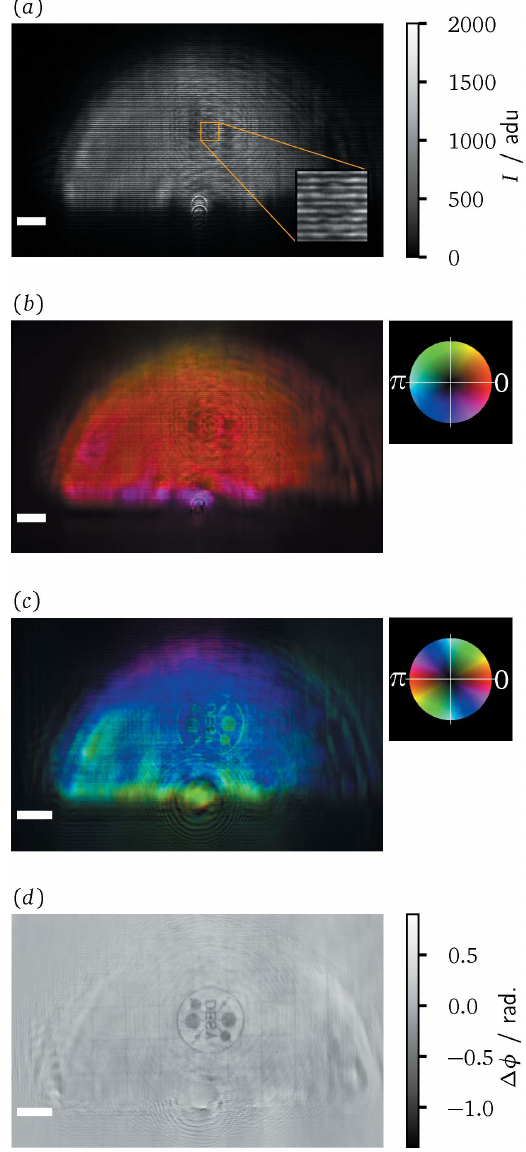
Figure 4 Overview of the data evaluation for grating interferometry. ( a ) Dark frame corrected raw data for a sample measurement in analog digital units (adu) of the sCMOS camera. The inset highlights the interference pattern over a region of 100 (cid:5) 100 pixels. ( b ) Complex wavefield reconstructed from this single-exposure data via the SIR method. The amplitude is mapped to brightness and the phase to hue, as indicated by the adjacent colour wheel. ( c ) Wavefield after backpropagation to the sample plane. ( d ) Phase shift of the sample after reference correction. The scale bar indicates 1 mm length in panels ( a ) and ( b ) and 10 m m in ( c ) and ( d